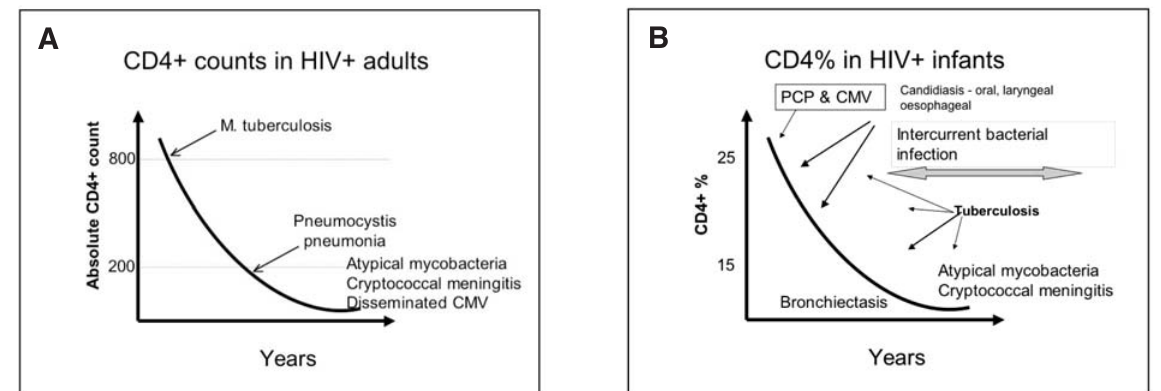
Fig. 1. Relationship between CD4 cells, disease and time in adults (A) and children